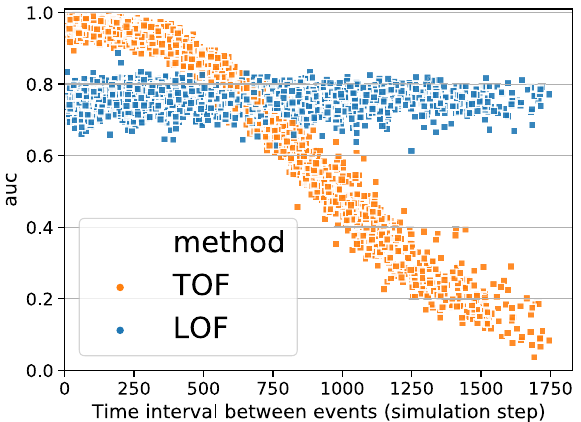
Figure 4. TOF detects unique events only. Detection performance measured by ROC AUC as a function of the minimum Inter-Event Interval (IEI) between two inserted tent-map outlier segments. TOF was able to distinguish outliers from the background very well when IEIs were below 300 steps, and the two events can be considered one. However, the detection performance of TOF decreased for higher IEIs. In contrast, LOF’s peak performance was lower, but independent of the